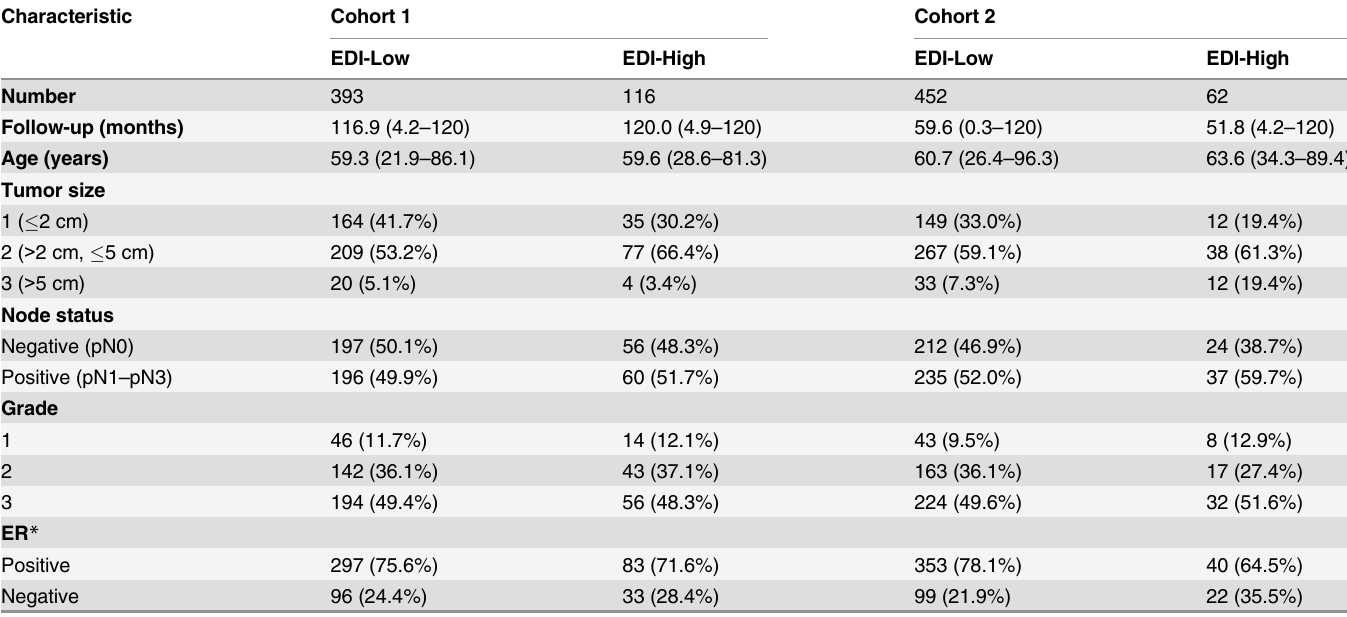
Table 1. Distribution of EDI scores and clinicopathological characteristics in breast tumors.